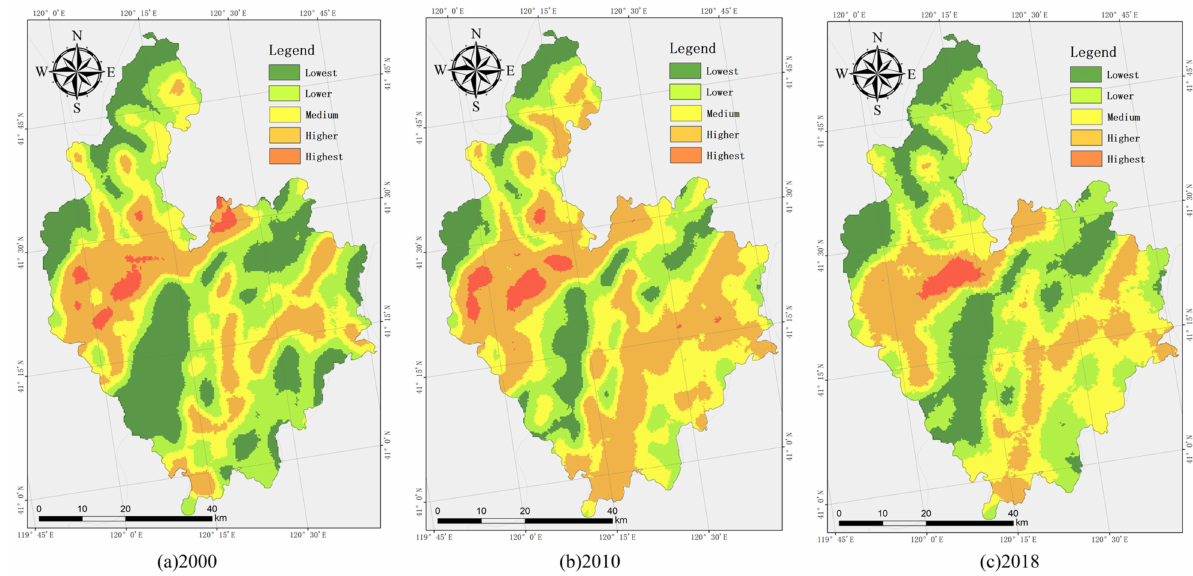
Figure 4. Landscape ecological risk level distribution of Chaoyang County in ( a ) 2000, ( b ) 2010, ( c ) 2018. From the perspective of temporal changes in landscape ecological risk, the ecological risk increased from 2000 to 2010 and decreased from 2010 to 2018 (Figure 5). medium risk and lower risk areas accounted for the largest proportion in the study area, up to 60%. Higher risk and lowest risk areas were followed, and the highest risk areas were the least. From 2000 to 2010, The lower and lowest risk areas decreased by 8.49% and 13.5%, respectively. And the higher risk areas rapidly increased by 14.64%. The combined effect was an increase in the ERI in this period. From 2010 to 2018, the higher risk areas decreased by 15.76%. The proportion of lower and lowest risk areas increased by 16.92%.